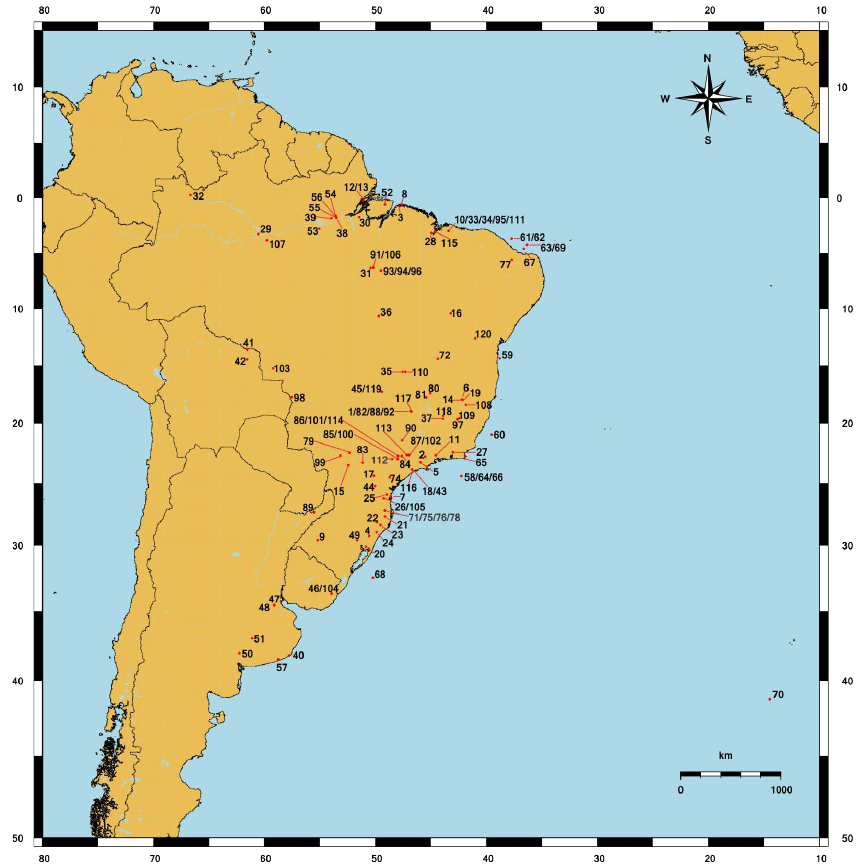
Fig. 3. Spatial distribution of the 120 palaeorecords (from 84 studies) used in this study. Vertical axis refers to latitude, and horizontal values correspond to longitude. Details for each record are found in Table